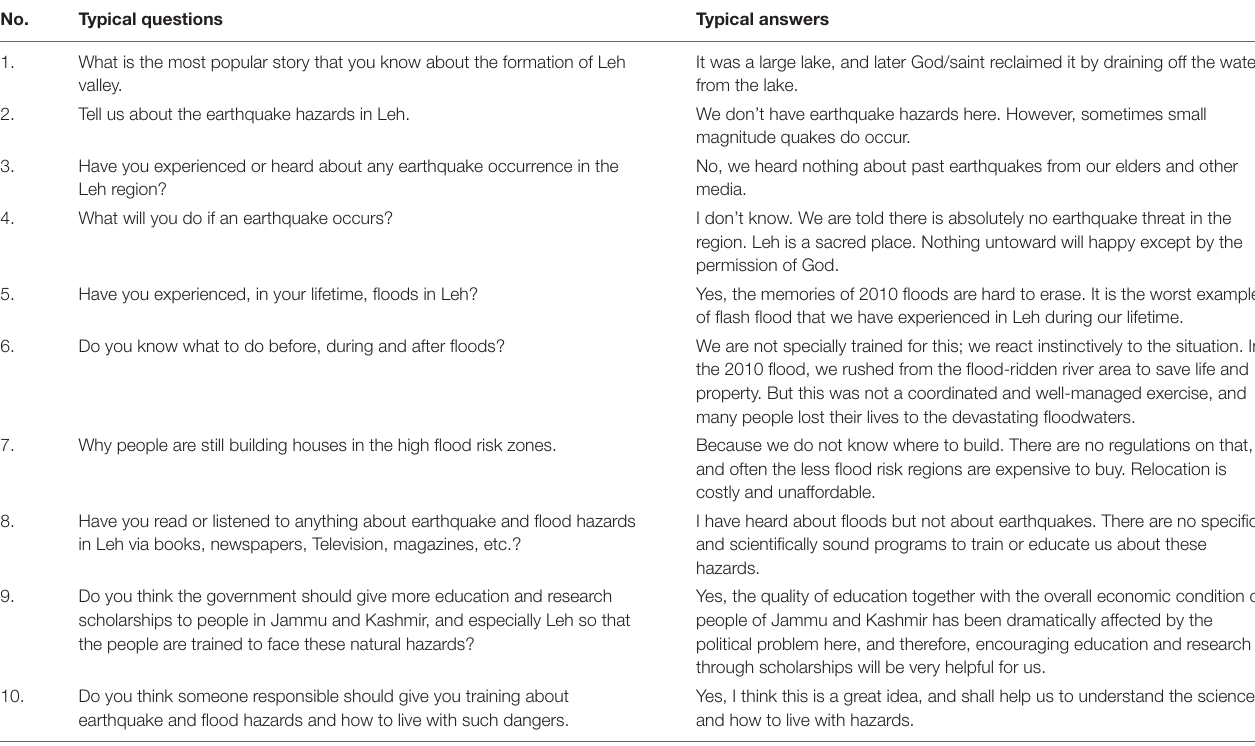
TABLE 1 | The typical questions and answer session with